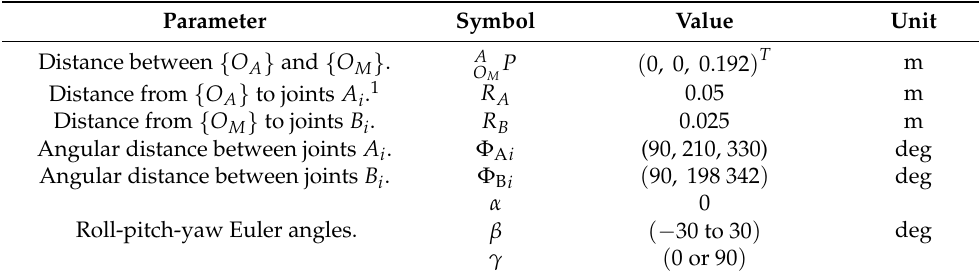
Table 1. Parameters and disposition of elements in parallel mechanism. Parameter